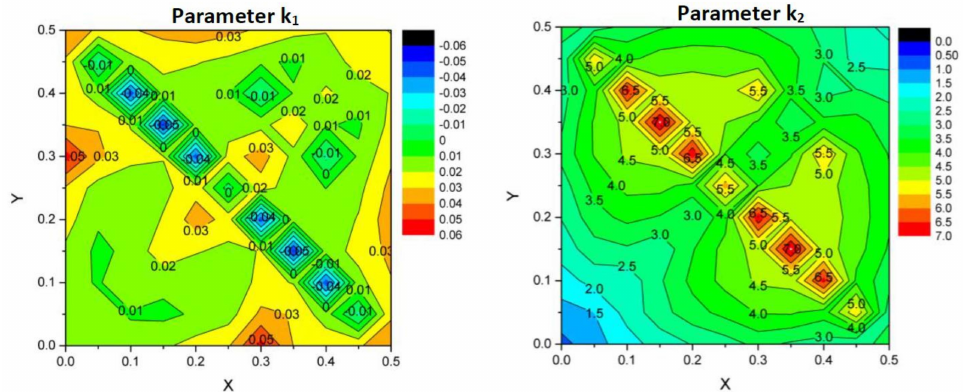
Figure 4. Polynomial parameters k 1 and k 2 for the dependence of density on the struts